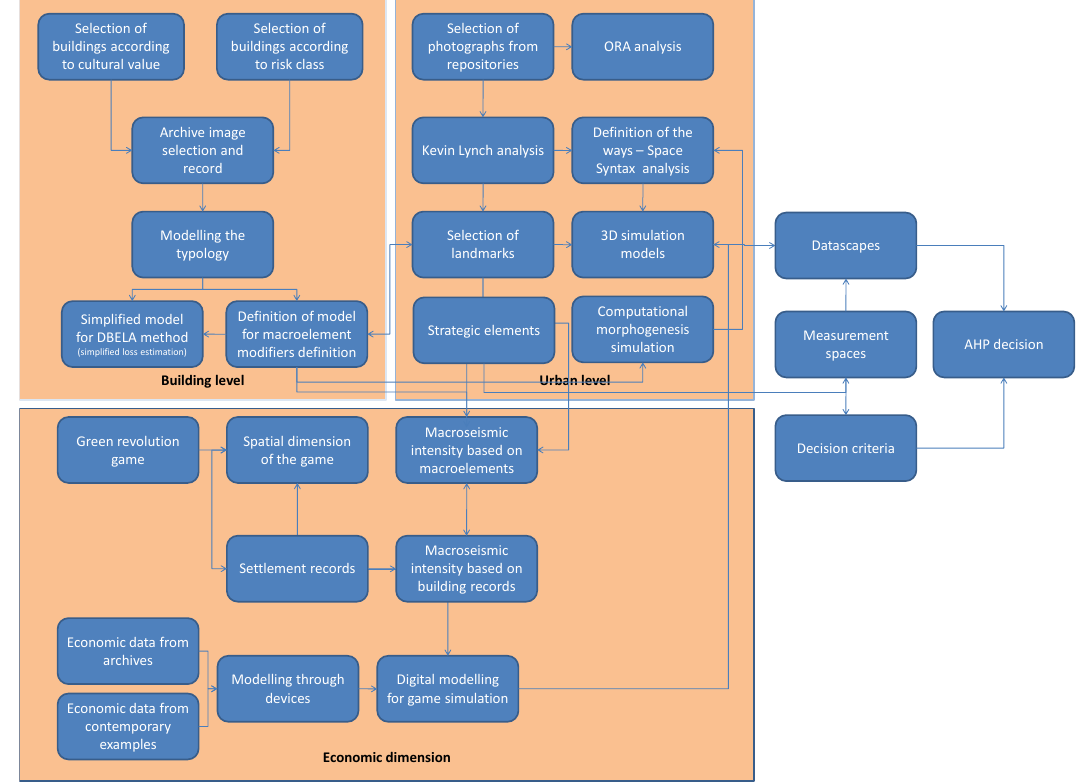
Figure 1. Methodology workflow with emphasis on those detailed in this paper.